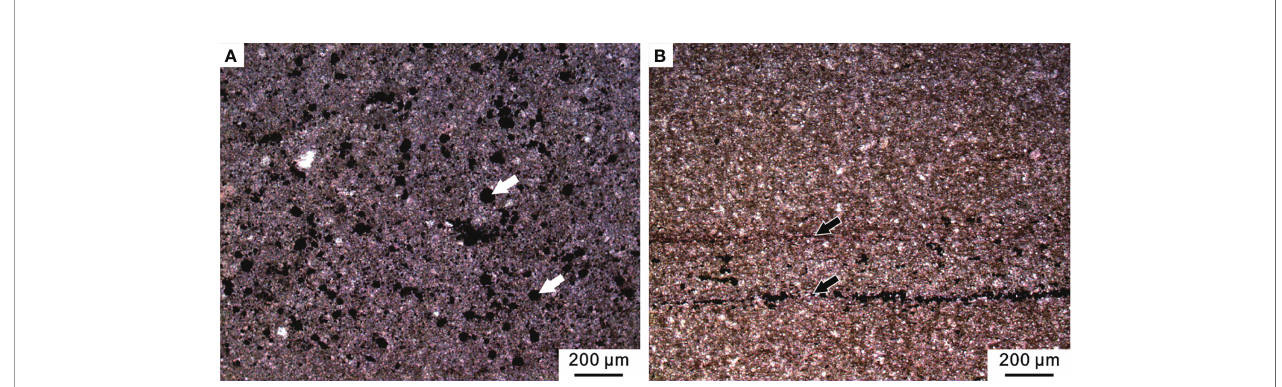
FIGURE 11 | Micropetrologic characters after the PTME. (A) Micrite from Bed 6 of the Chongyang section bearing abundant pyrite framboids (white arrows). (B) Mudstone from Bed 19 of the Chibi section, including organic laminas (black arrows).